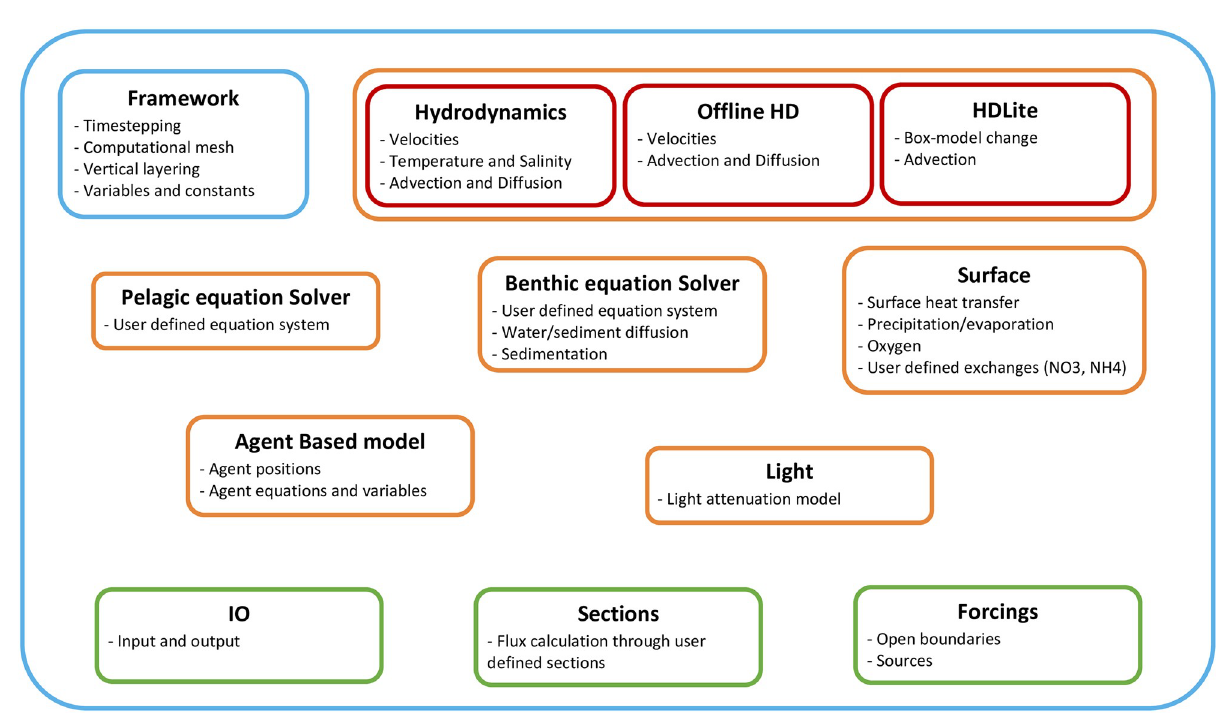
Fig 2. Framework modules. All modules (orange) in the framework can run independently or fully coupled, except the three hydrodynamic (HD) modules (red), which are alternatives. The only mandatory part is the framework it itself (blue), which defines the computational mesh, simulation period, overall timestepping, variables and constants. Additional functionality are Input/output, sections and forcings